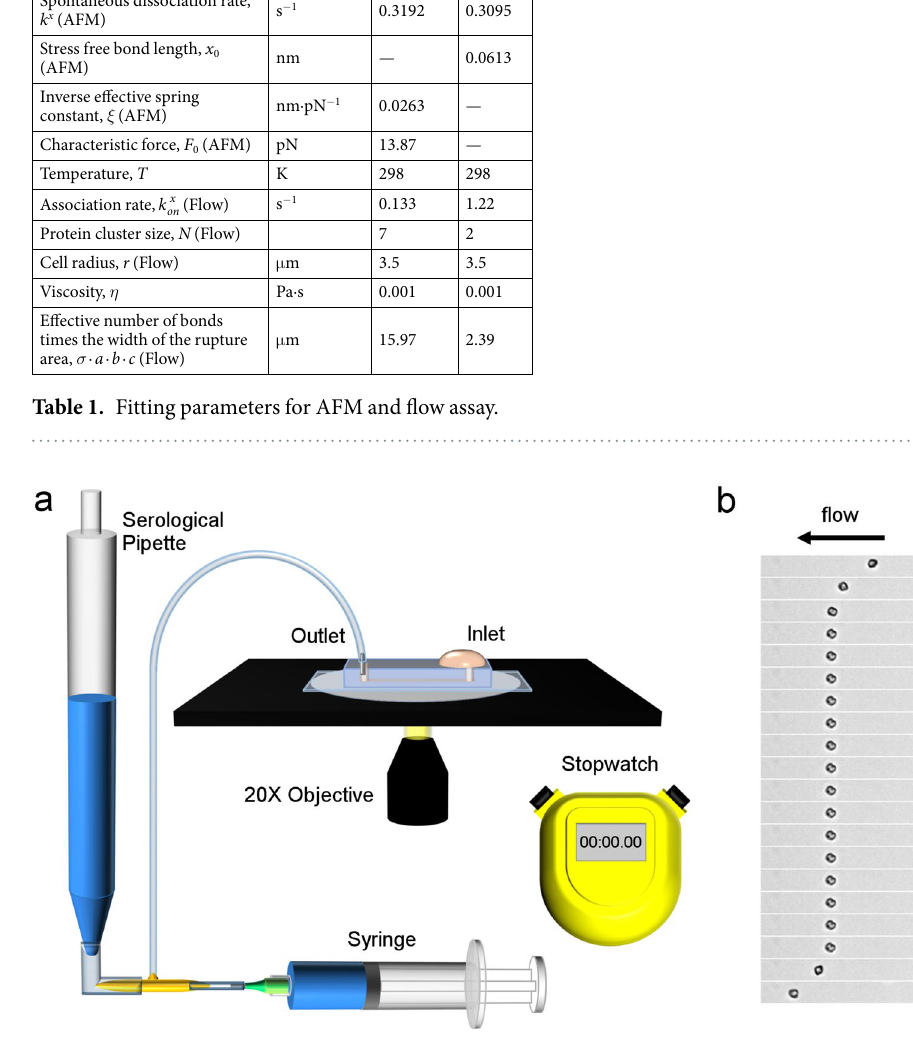
Figure 3. Multiple bond flow experiment. Panel a: Schematic of flow experiment set-up. Panel b: Time lapse image of infected red blood cell adhering in the flow chamber. Each image corresponds to a time difference of 200